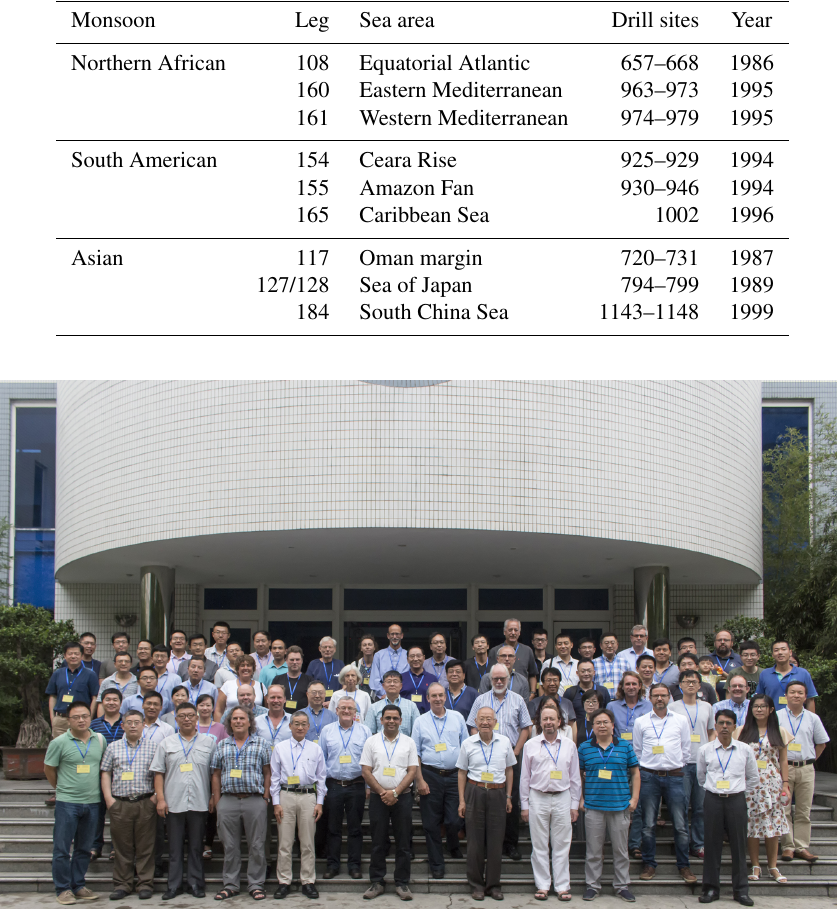
Table 2. ODP monsoon expeditions.